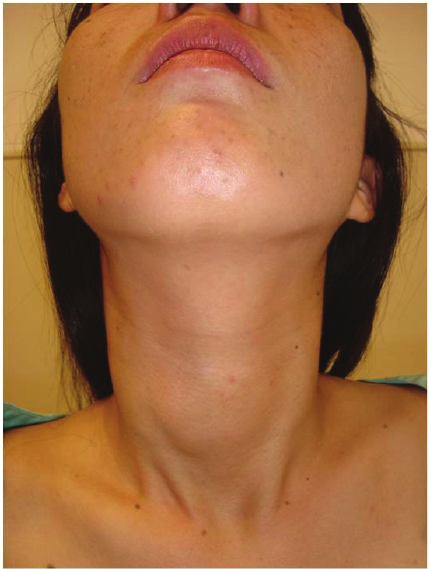
Figure 1: Local condition preoperatively.